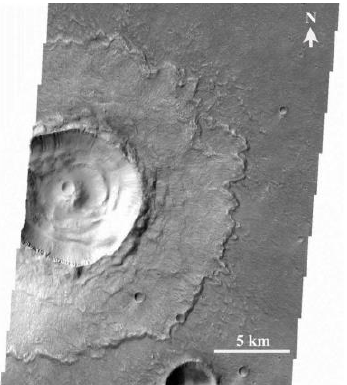
Figure 1. Example of a SLE crater (THEMIS